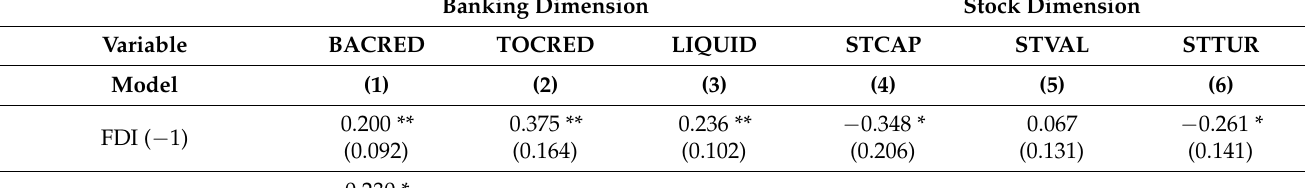
Table 5. The regression results for the impact of financial development on